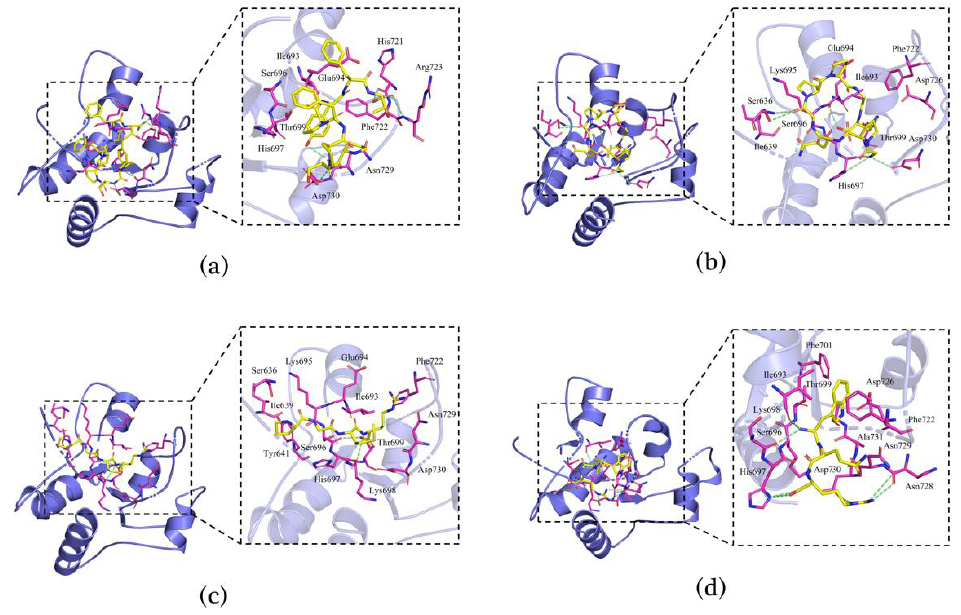
Figure 6. Binding and interacting residues of peptides with TLR2 (ID: 1FYW). PSPFPYFT-TLR2 ( a ), GPQGPPGH-TLR2 ( b ), PGMR-TLR2 ( c ), and WQR-TLR2 ( d ). In the figure, green represents hydrogen bonds, yellow represents polypeptide ligands, and purple represents amino acid residues related to the action.